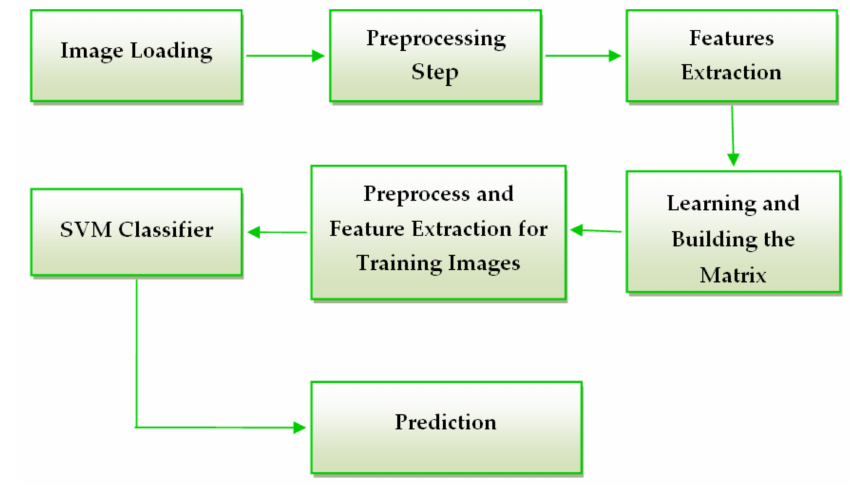
Figure 7. Flow chart of the proposed